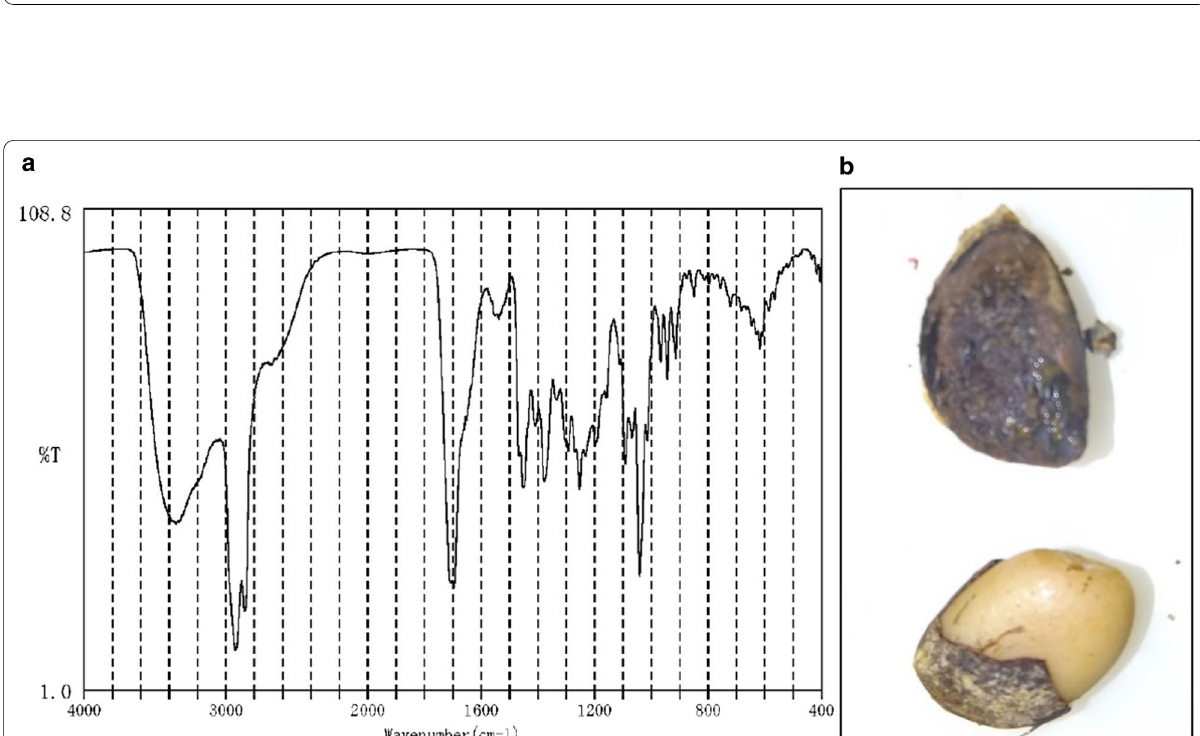
Fig. 4 Intraoperative findings and resected specimens. a The 3-cm perforation site of the small intestine (white arrowheads); b the severely adhered resected small intestine; c the specimen after lysis and opening; d the largest stone is spherical and approximately 5 cm in size